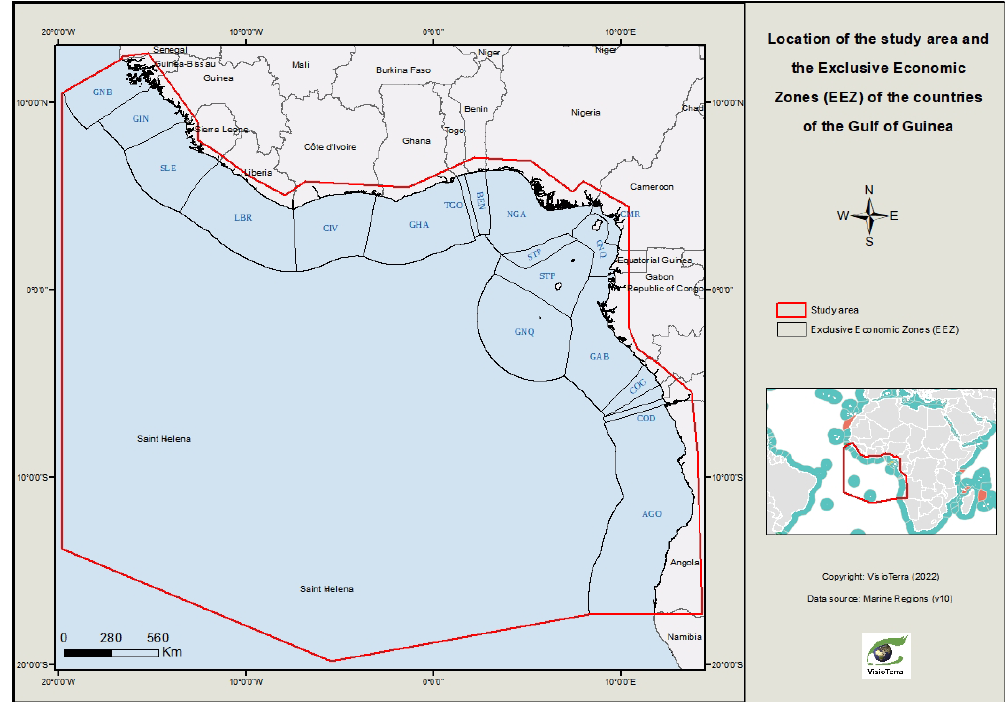
Figure 1. Location of the study area in the Gulf of Guinea and the exclusive economic zones (EEZs) of the different countries.